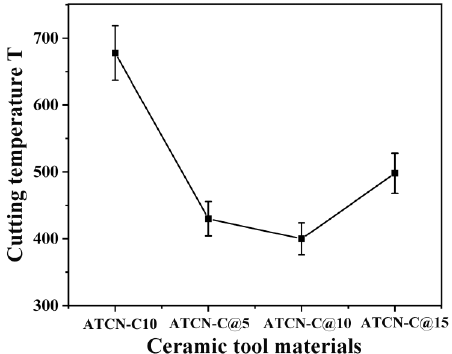
Figure 5. Comparison of cutting forces of four ceramic cutting tools (test conditions: depth of cut α p = 0.2 mm, feed rates 𝑓 = 0.102 mm/r, cutting speed υ = 300 m/min).